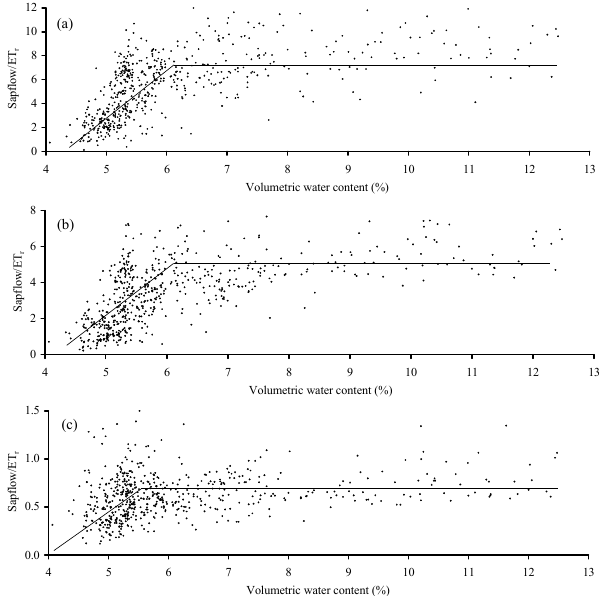
Fig. 10. The ratio of sap flow to reference evaporation versus the soil water content (0.075m) at the Dune Forest site for (a) Mimusops caffra , (b) Eugenia natalitia and (c) Drypetes natalensis with the solid line representing the split-line